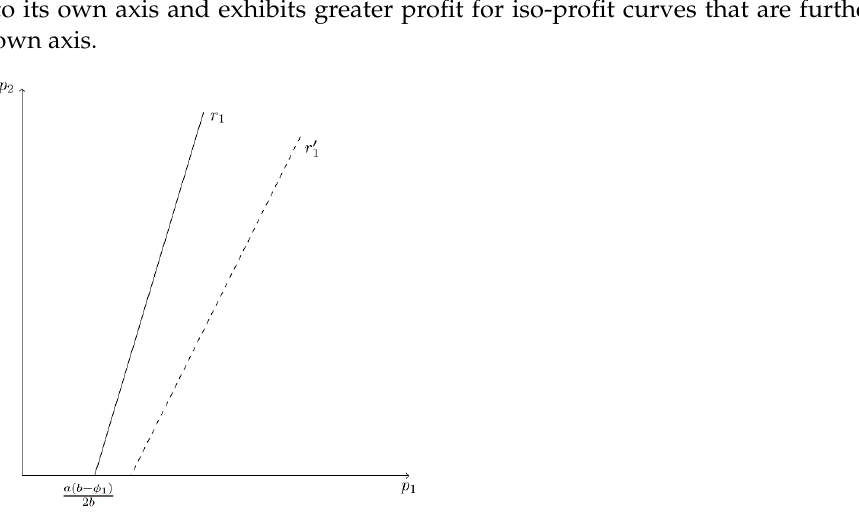
Figure 6. Firm 1’s Best-Reply Curve in the Bertrand Model When CEO 1 Underestimates Product Figure 6. Firm 1 ʹ s Best ‐ Reply Curve in the Bertrand Model When CEO 1 Underestimates Product Substitutability. Substitutability.